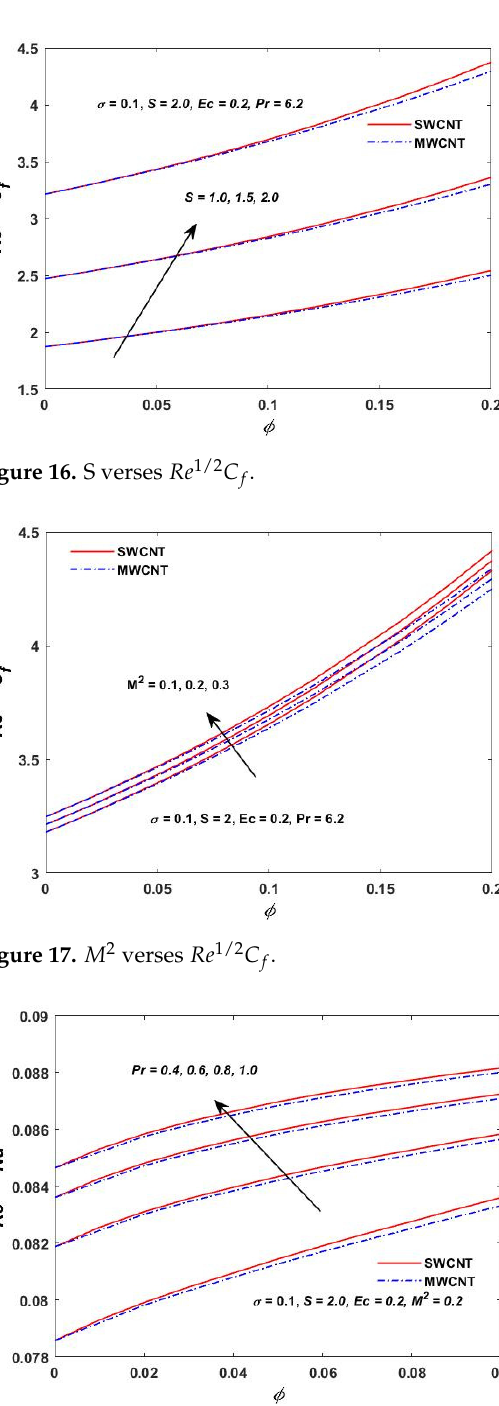
Figure 15. 𝑀 (cid:2870) verses Prandtl and 𝑅𝑒 (cid:2869)/(cid:2870) 𝐶 (cid:3033) .